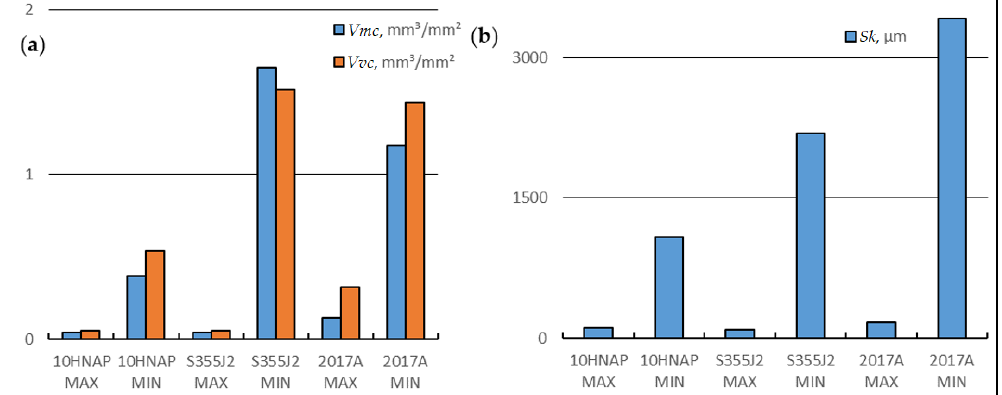
Figure 13. Fracture surface properties (( a ) Vmc and Vvc ; ( b ) Sk ) for extremal fractal dimension cases.